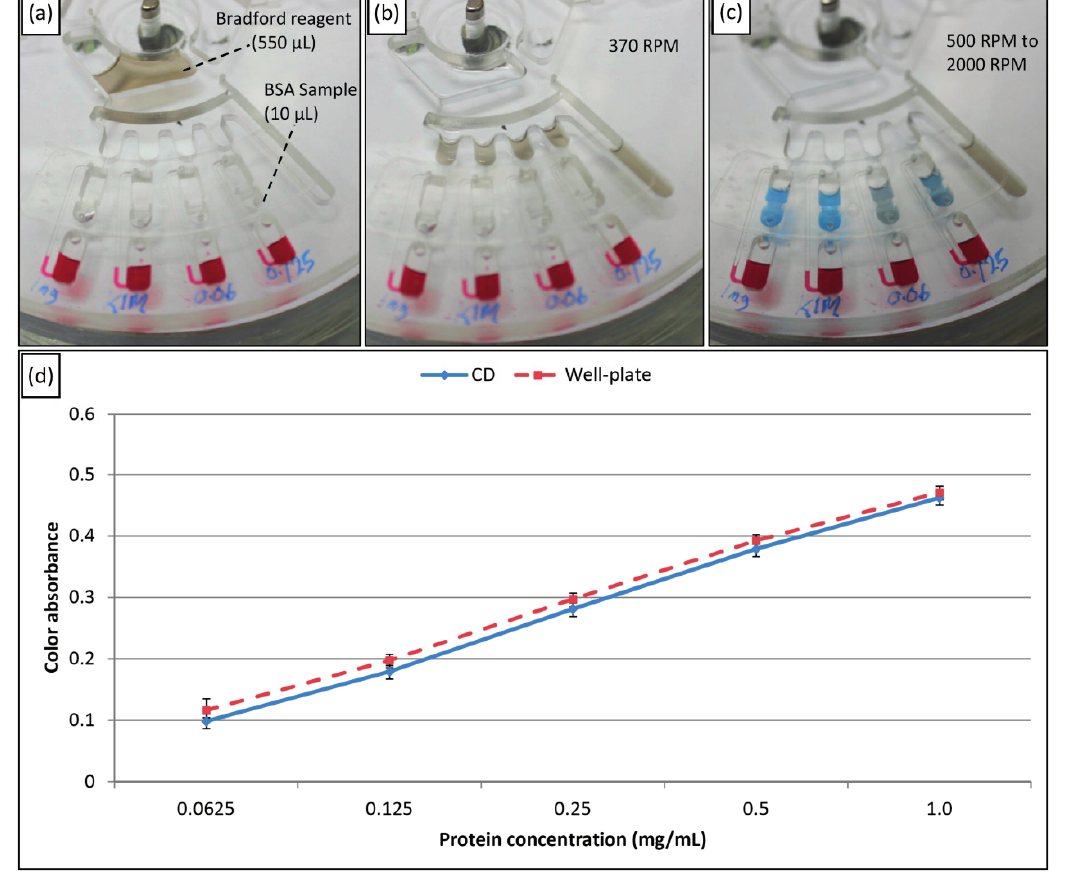
Figure 8. Experimental result of a Bradford assay to measure the protein concentration, ( a ) spinning speed less than 370 RPM, with the Bradford reagent in the source chamber and the samples in the destination chambers, ( b ) The Bradford reagent bursts and fill the metering chambers at 370 RPM, ( c ) the Bradford reagent bursts from the metering chamber to the destination chambers to mix with the BSA samples (500 RPM to 2000 RPM), and ( d ) results for different BSA samples with different concentrations using the microfluidic CD and the micro-well plate as assay